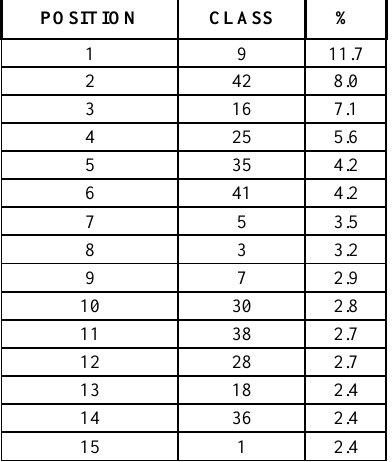
Table 3: Applications Based on Class – First 15 (Totals, %) POSITION CLASS